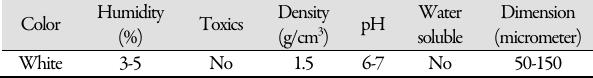
Table1. Super absorbent polymer (Taravat A200)